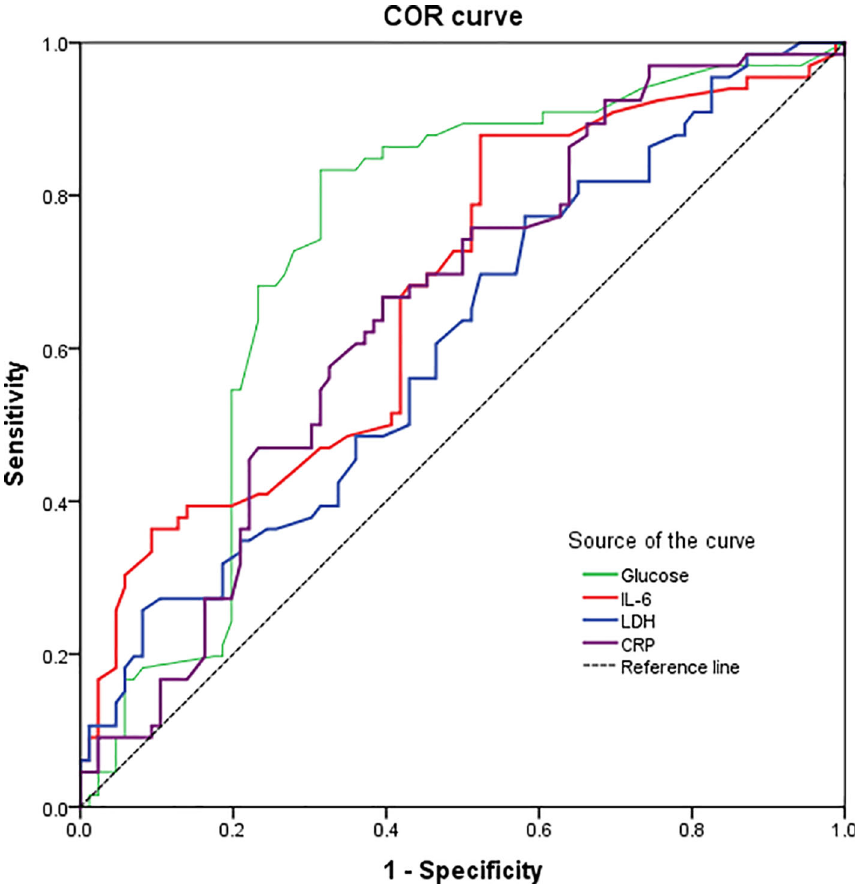
Figure. 2. Receiver operating characteristics (ROC) curve of significant laboratory parameters showing the predictive power of glucose, IL-6, LDH and CRP in the COVID-19 severity. Abbreviations: CRP: C-reactive protein; IL-6: interleukin-6; LDH: lactate